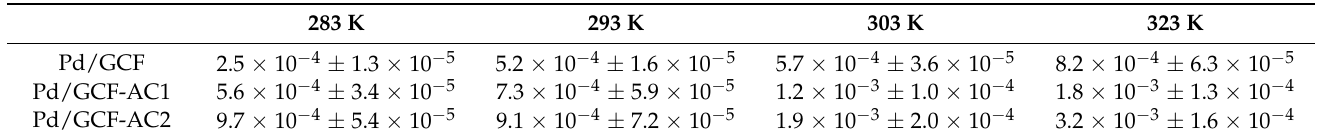
Table 2. Reaction rate constants (k) in s − 1 dependence on the reaction temperature.